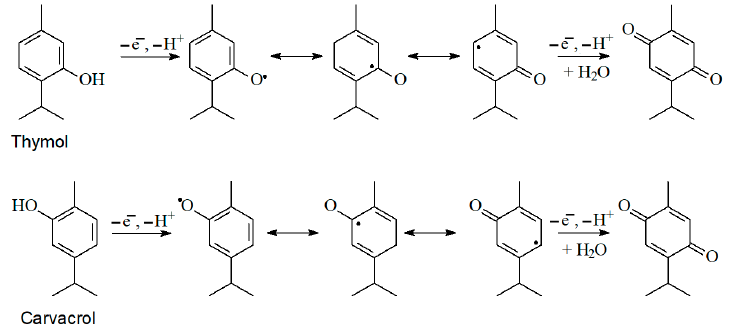
Figure 9. E ff ect of the modulation parameters on the voltammetric characteristics of 10 µM thymol Figure 9. Effect of the modulation parameters on the voltammetric characteristics of 10 µ M thymol at at the polythymolphthalein/MWCNTs/GCE in Bri tt on-Robinson bu ff er pH 2.0: ( a ) oxidation poten- the polythymolphthalein/MWCNTs/GCE in Britton-Robinson buffer pH 2.0: ( a ) oxidation potential; tial; ( b ) oxidation current. The potential scan rate is 20 mV s − 1 . ( b ) oxidation current. The potential scan rate is 20 mV s − 1